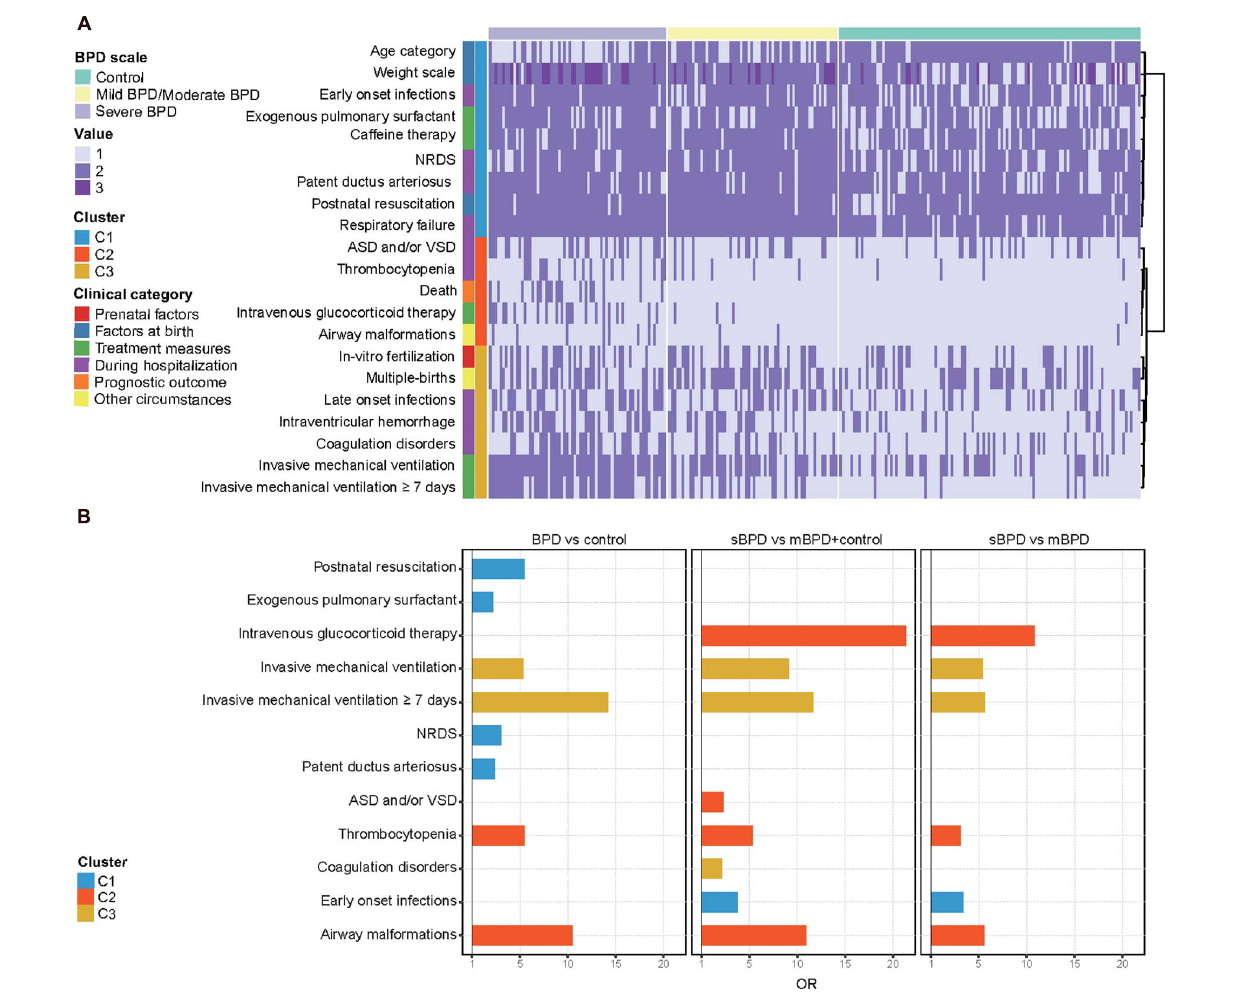
FIGURE 2 | Distribution of infant clinical characteristics. (A) Cluster analysis of clinical characteristics of all infants. (B) Significant clinical characteristics in three comparisons. Twenty-one clinical characteristics that significantly differed between bronchopulmonary dysplasia (BPD) and controls or between any two BPD levels ( p < 0.05) were selected. Weight scale including low BW (1,500–2,499 g), very low BW (1,000–1,499 g), and extremely low BW ( < 1,000 g) were represented by values 1–3, respectively. Age category including extremely preterm ( < 28 weeks) and very preterm (28 to 32 weeks) was represented by values 1 and 2, respectively. ASD/VSD, atrial septal defect/ventricular septal defects; NRDS, neonatal respiratory distress syndrome; sBPD, severe BPD; mBPD, mild and moderate BPD.